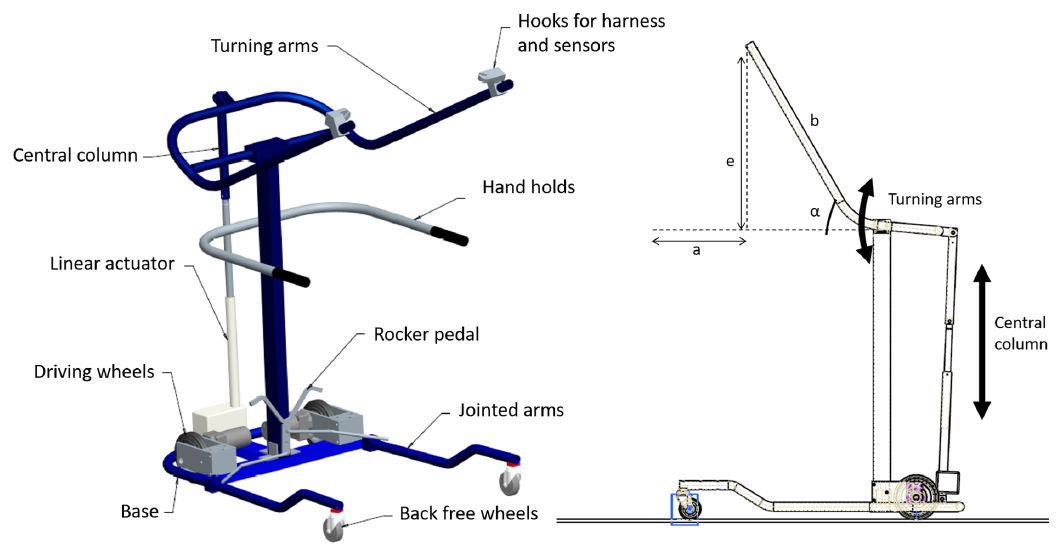
Figure 8. REMOVI mechanical structure.